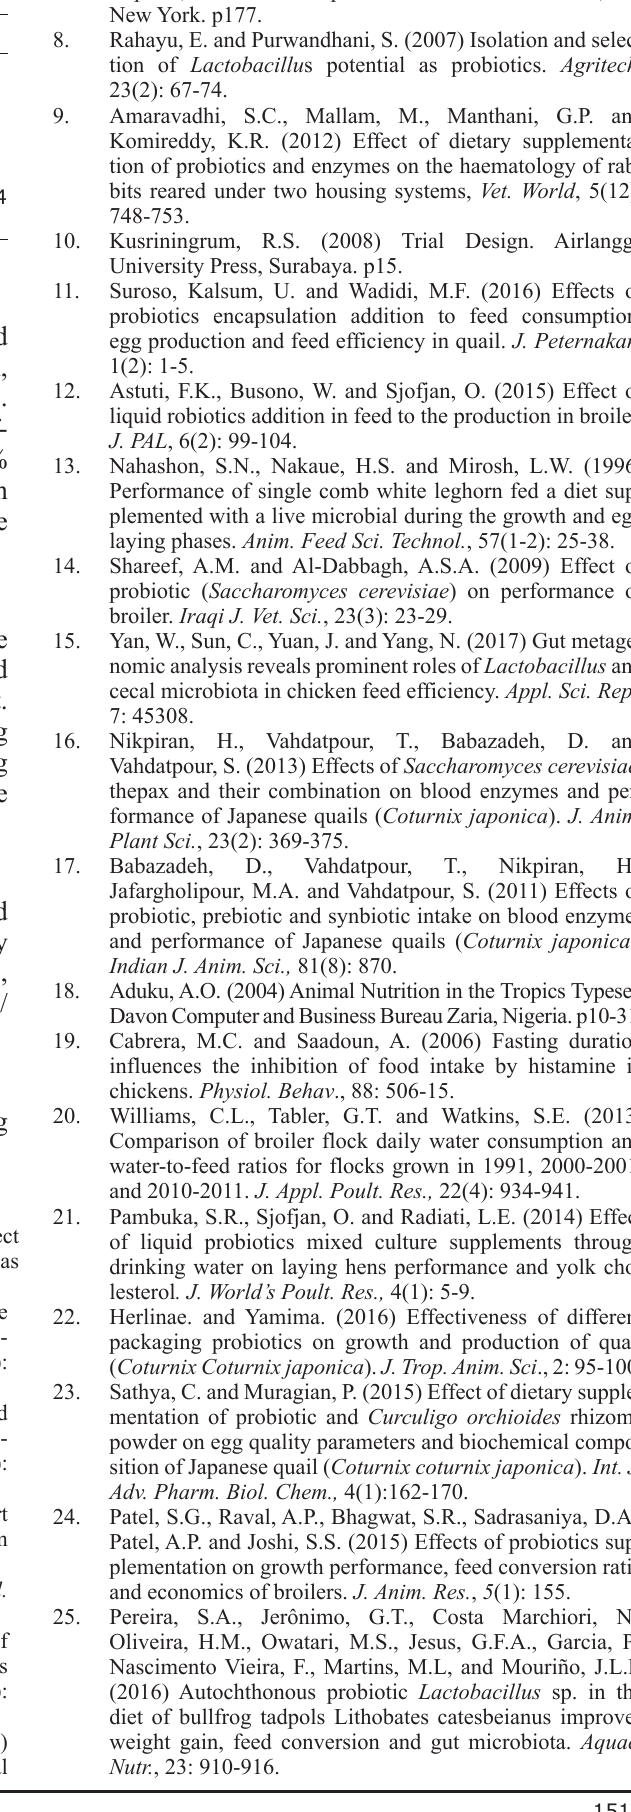
Table-7: Economics analysis each treatment. Description